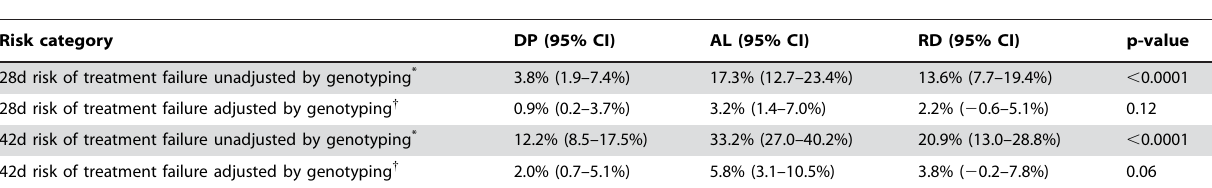
Table 3. Estimates of comparative efficacy